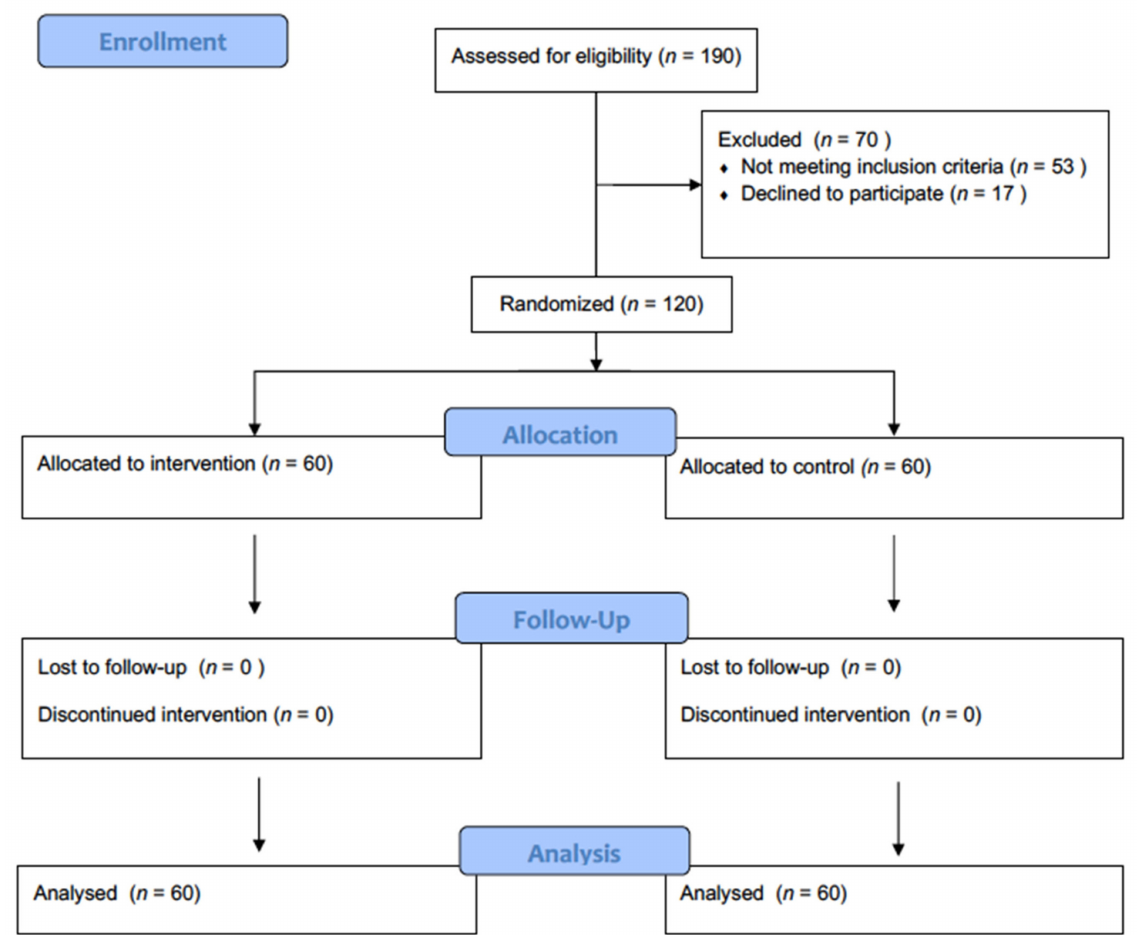
Figure 1. Flow-chart of the